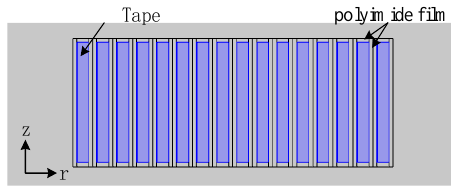
Figure 10. The model of the 16-turn coil.